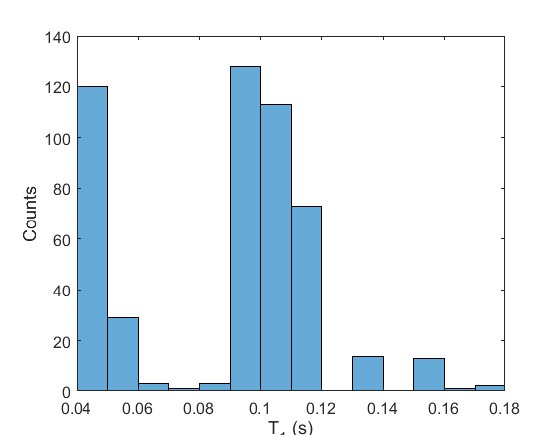
Figure 8. Histogram of times of application of u 1 in the real system.